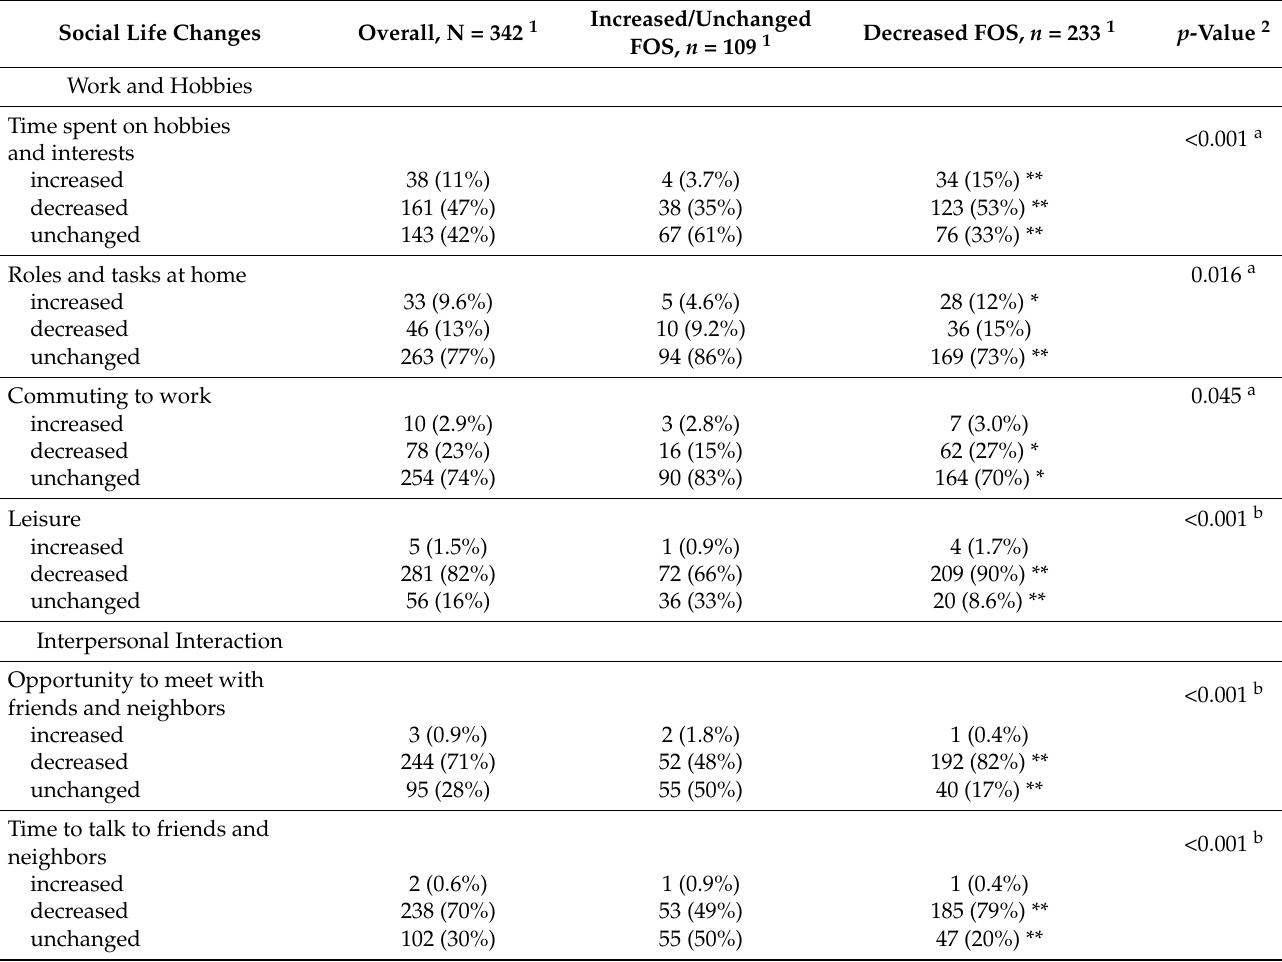
Table 3. Bivariate statistics for social life changes by frequency of